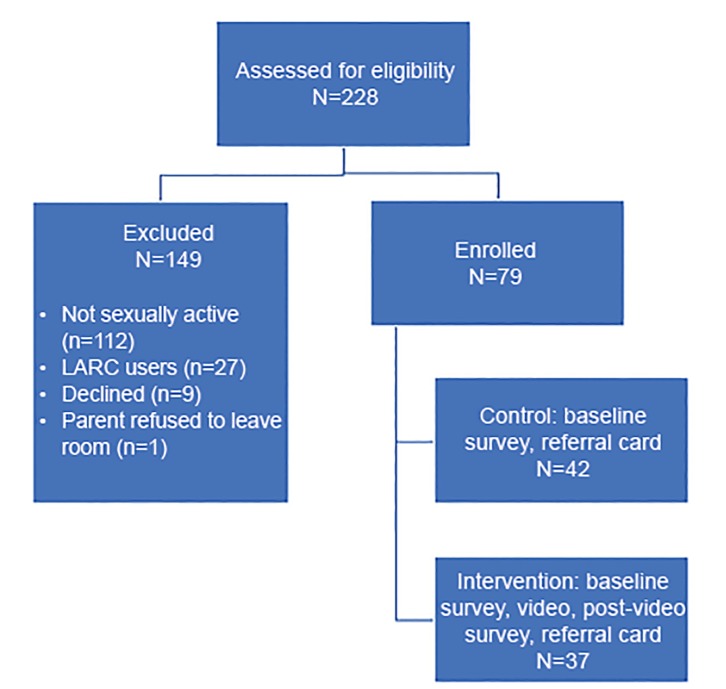
Consolidated Standards of Reporting Trials (CONSORT) diagram demonstrating selection and randomization of subjects in study of adolescent girls’ response to education on pregnancy prevention options in the emergency department.LARC, long-acting reversible contraceptive.